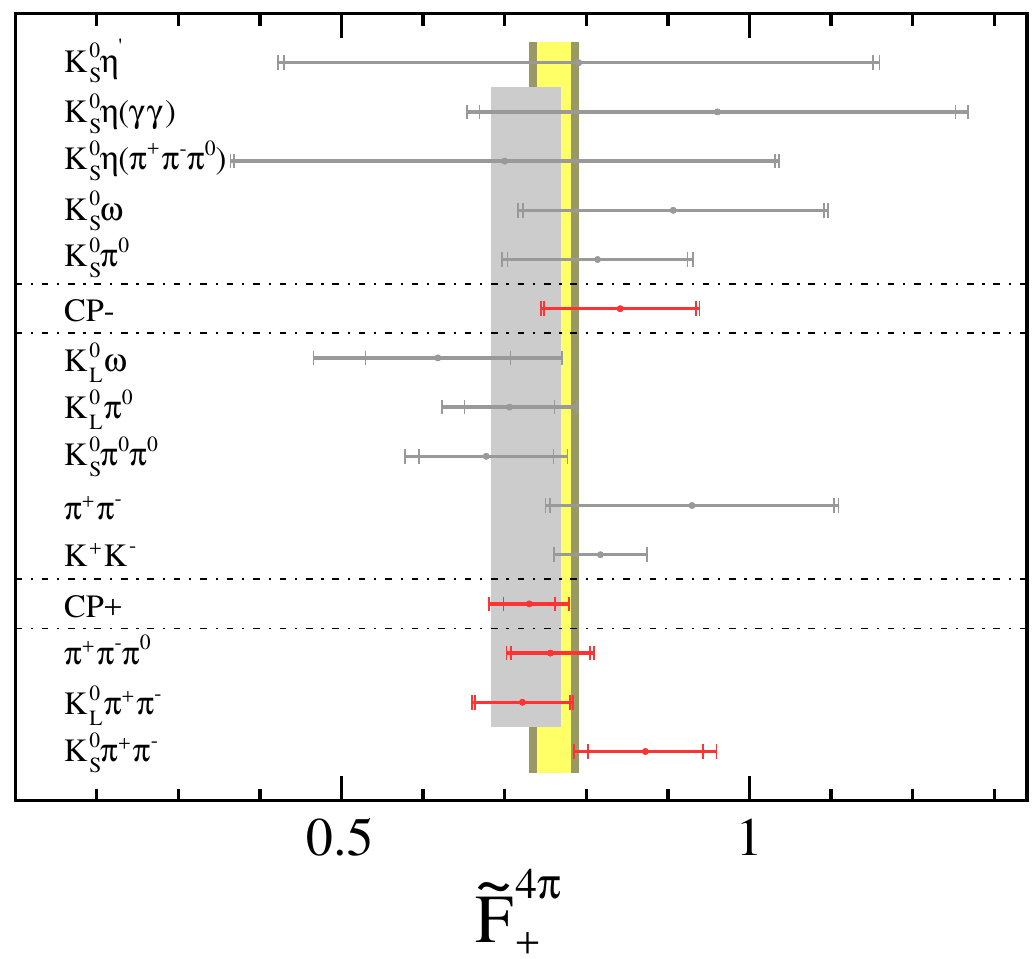
Figure 12 . The CP -even fraction over all phase space bins, ~ F 4 (cid:25) , determined using di(cid:11)erent subsets + of tags. The grey bands show the model predictions and uncertainties. The red/grey lines show the measured values and uncertainties when using a single subset of tags | the inner error bar shows the statistical uncertainty, and the outer error bar shows the combined statistical and systematic uncertainty. The yellow band shows the combined result using all subsets of tags | the lighter shade of yellow represents the statistical uncertainty, and the darker shade of yellow shows the combined statistical and systematic